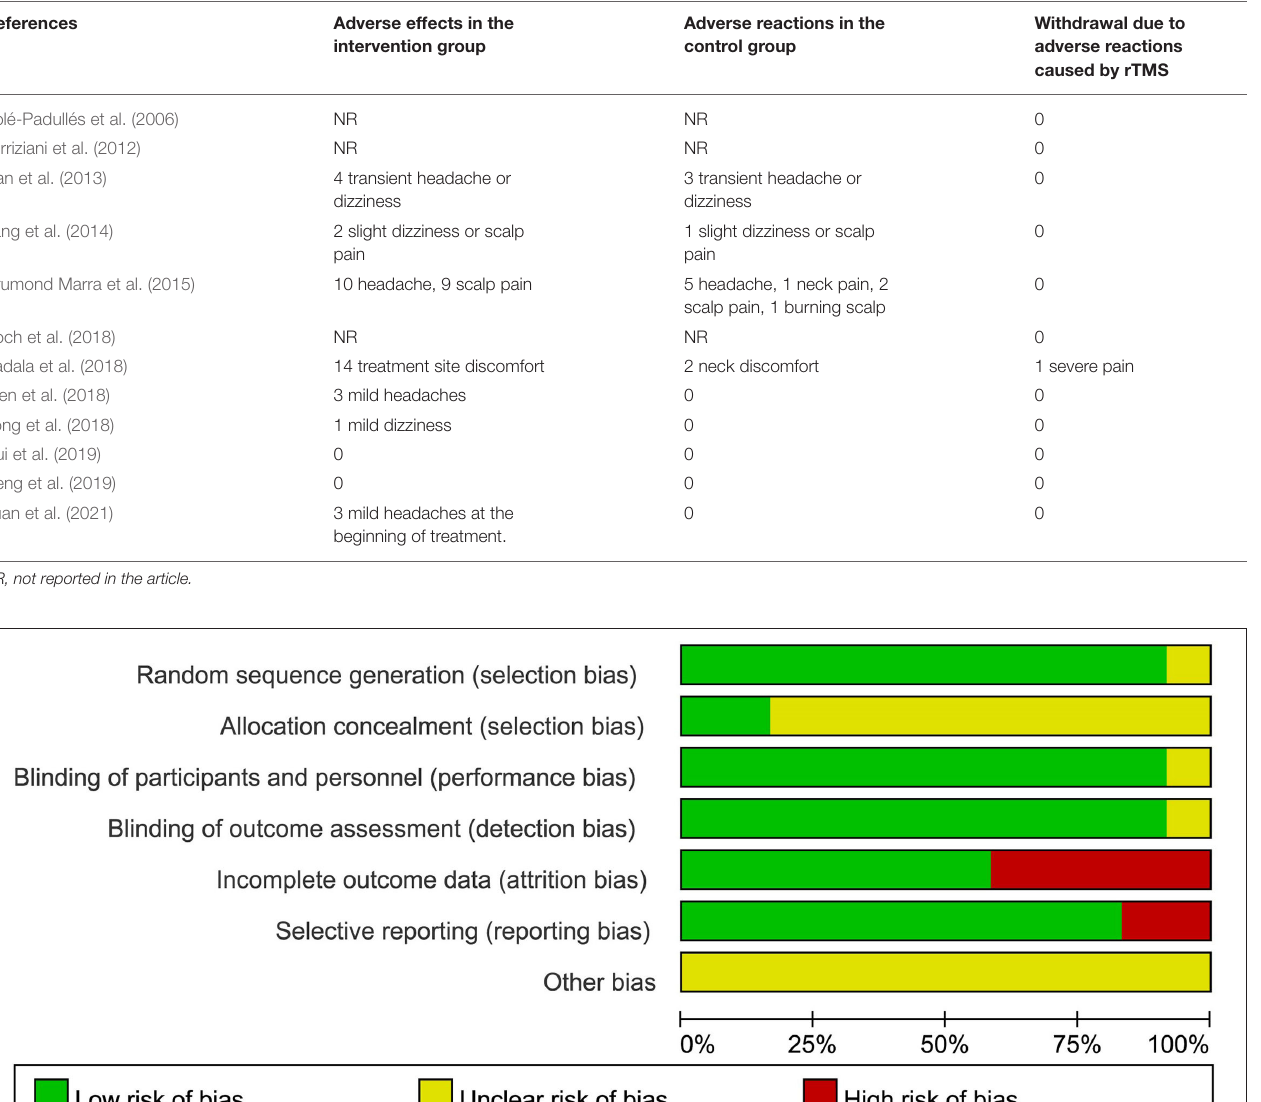
moderate between-study heterogeneity ( I 2